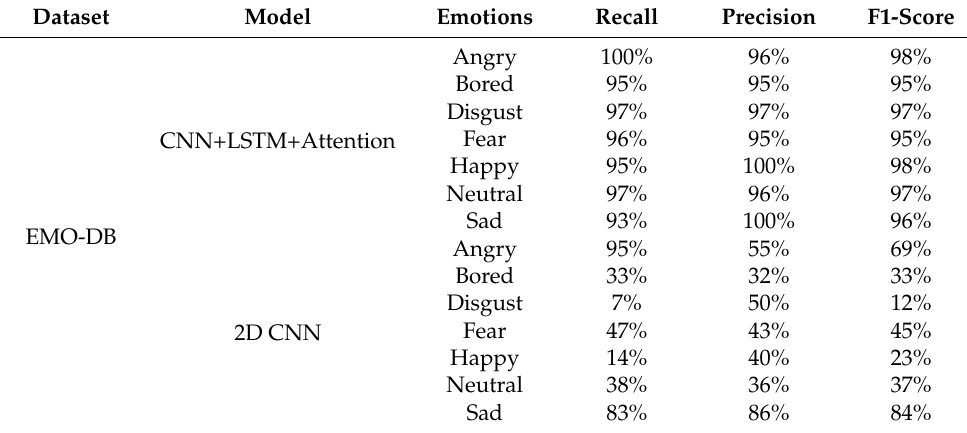
Table 5. Individual class performance evaluation